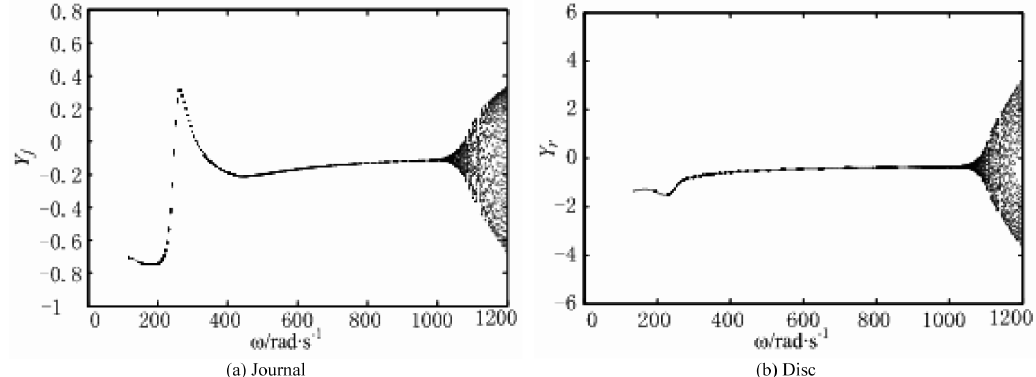
Fig. 4. Bifurcation diagrams of the shaft and the disc (without the pad’s moment of inertia).